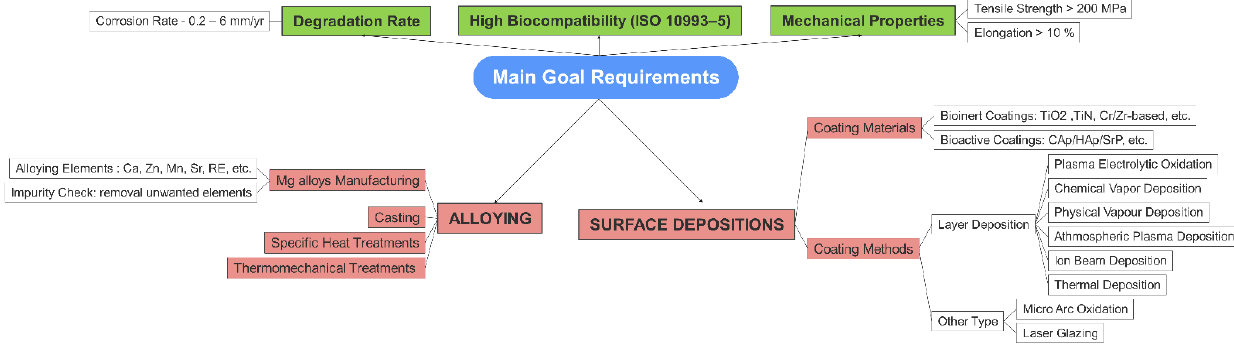
Figure 3. Main goal requirements of Mg-based alloys [22–24].